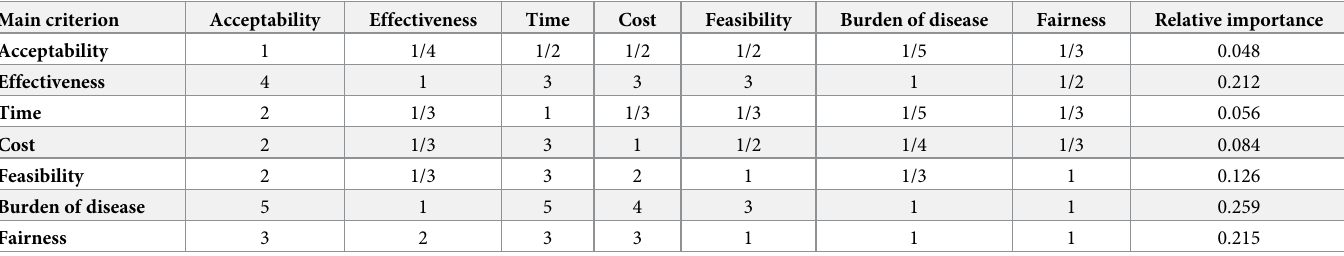
Table 2. Matrix of pairwise